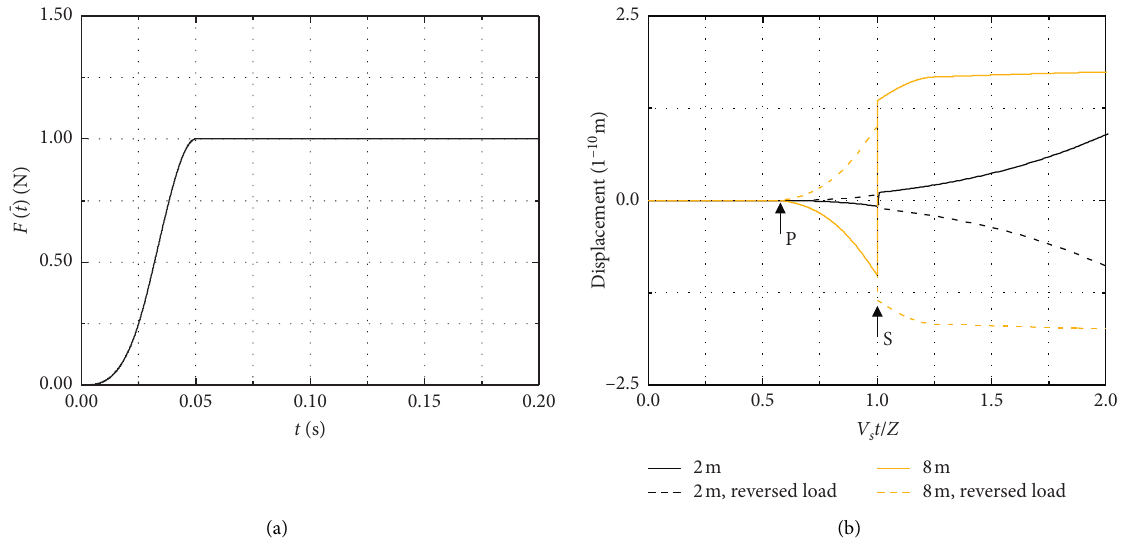
Figure 3: Analytical method result. (a) Approximate Heaviside unit function used for the analytical method. (b) Displacements of 2m and 8m in an elastic half-space directly below the surface tangential point source. Poisson’s ratio is 0.25.